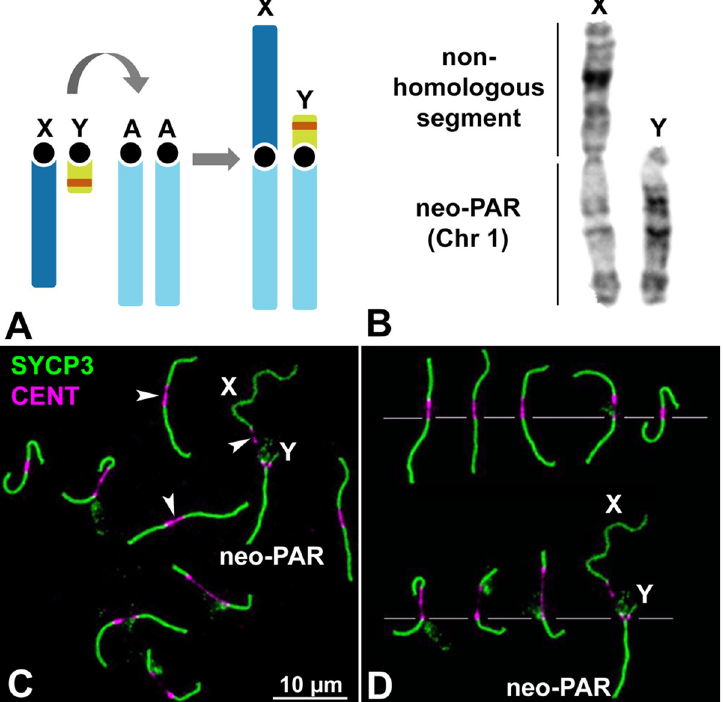
Fig 1. Sex chromosomes in M . minutoides . A . Schematic representation of the Rb translocation between the sex chromosomes (X and Y) and autosomal chromosome 1 (A). The ancestral sex chromosomes are completely differentiated and, thus, achiasmate. The translocation results in a large neo-PAR constituted by chromosome 1. The orange band in the Y chromosome represents the sex-determining locus. B . G-banding of the sex chromosomes indicating the neo-PAR and the non-homologous segment. C . Spread spermatocyte at pachytene labelled with antibodies against SYCP3 (green) and centromeres (magenta). The trajectories of SCs are interrupted at the centromeres, which appear largely stretched (arrowheads). Non-homologous segments of the sex chromosomes (X, Y) and the neo-PAR are indicated. D . Meiotic karyotype of M . minutoides . Bivalents are arranged according to the length of their largest arm, as previously described [50, 72]. The sex bivalent is largely heteromorphic in the non-homologous segments.